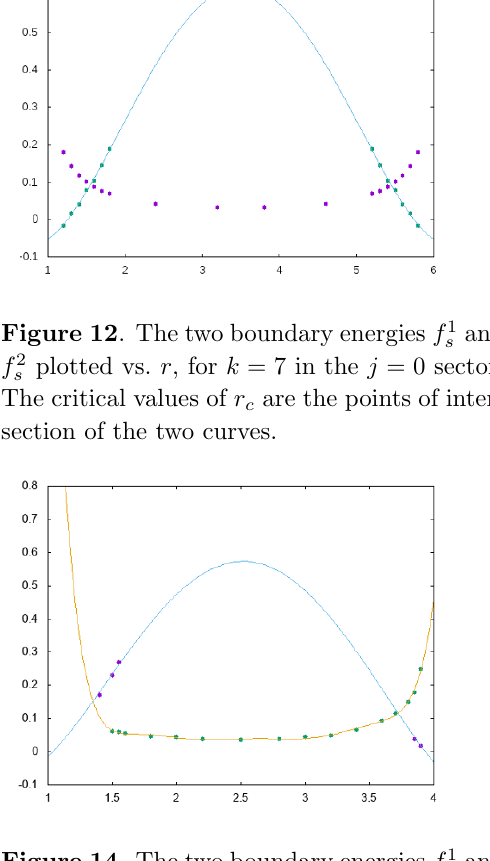
and Figure 14 . The two boundary energies f 1 s f 2 plotted vs. r , for k = 5 in the j = 3 unblob s sector. The critical values of r c are the points of intersection of the two